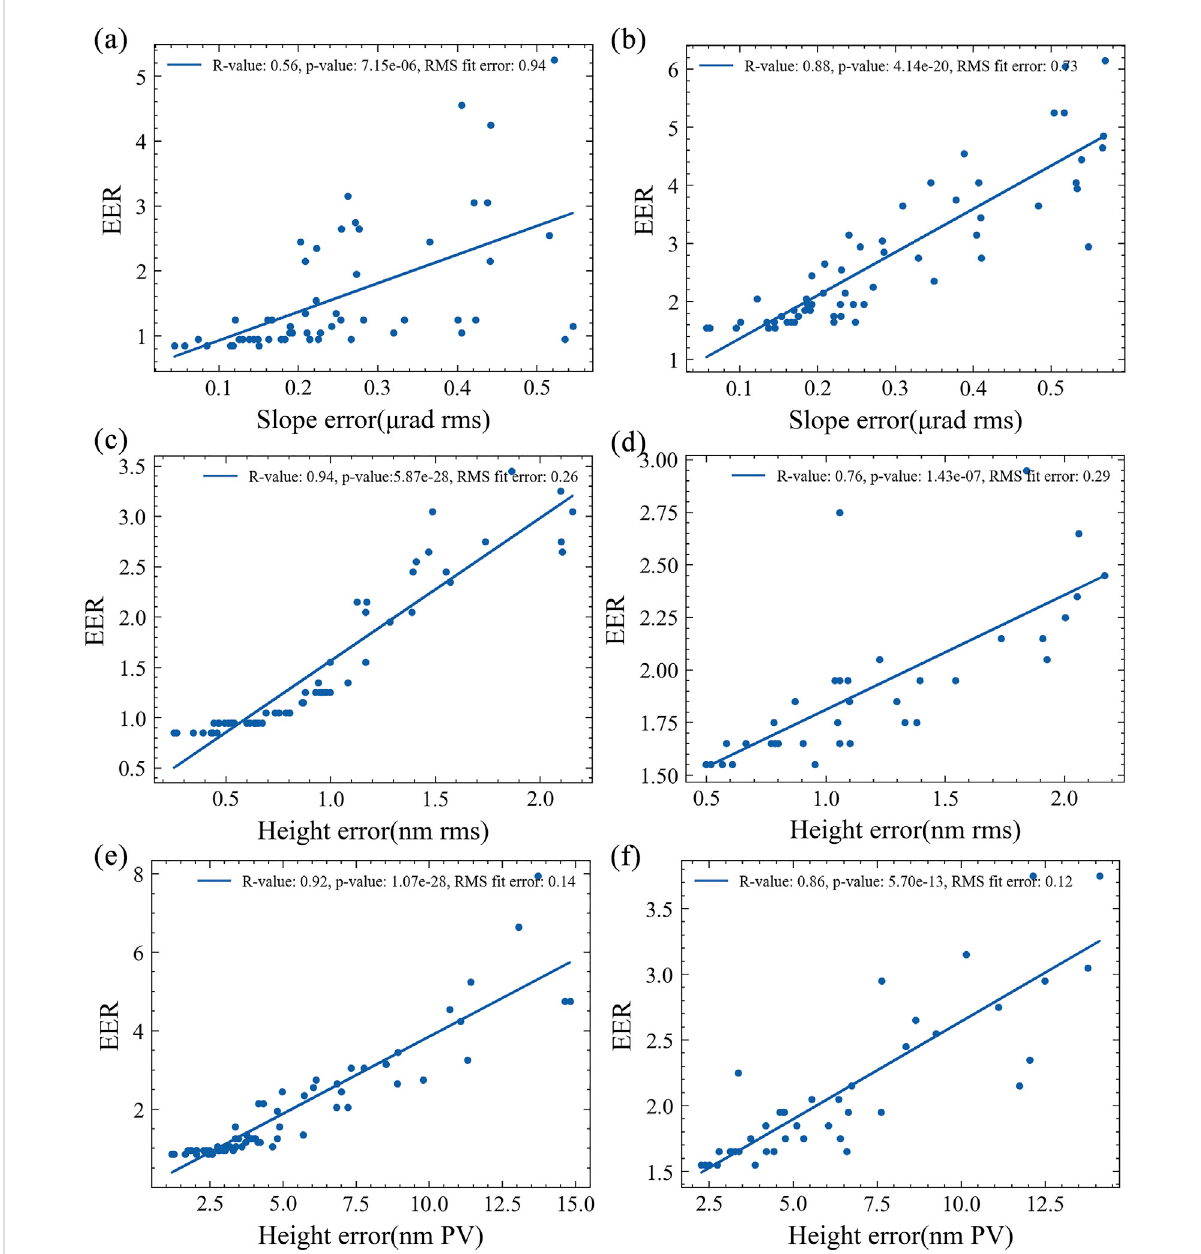
FIGURE 13 Encircled energy spot radius by values of RMS slope error (A,B) , RMS height error (C,D) and PV height error (E,F) . The left and right columns correspondto 10 μ rad acceptanceangleinverticaldirectionand18 μ rad acceptanceangleinhorizontaldirection,respectively. Thecriterionforthe encircled energy spot radius width is